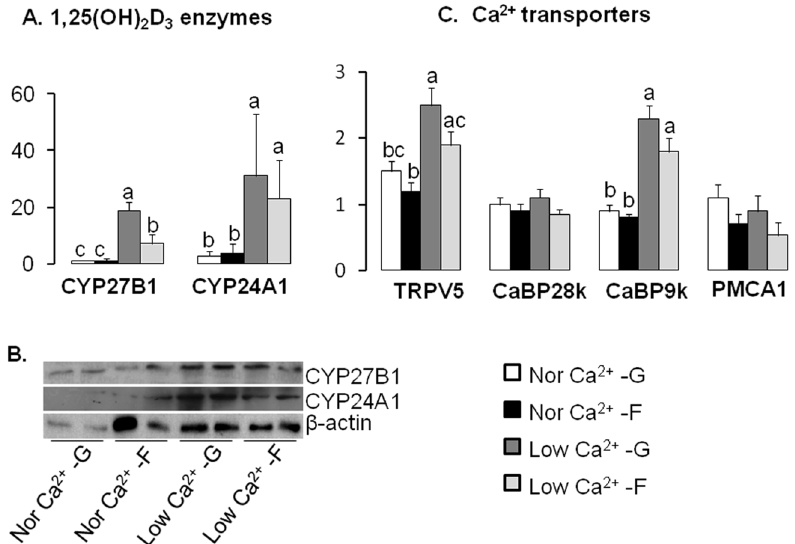
Figure 2. Fructose inhibits compensatory increases in renal expression of the 1,25(OH) 2 D 3 metabolizing enzyme CYP27B1 induced by dietary Ca 2 + deficiency in mice. (A) mRNA expression levels of renal CYP27B1 (1 a -hydroxylase) and CYP24A1 (24-hydroxylase). (B) The protein abundance of CYP27B1 and CYP24A1, using b -actin as a reference. (C) mRNA expression levels of renal TRPV6, CaBP28k, CaBP9k and PMCA1. Nor = normal; G = glucose; F = fructose. All mRNA expression level data were analyzed by real-time PCR using EF1 a as a reference and normalized to levels in mice fed glucose and normal Ca 2 + diet. Data are means 6 SEM ( n =5–6 per group). Differences ( P , 0.05) among means are indicated by differences in superscript letters, as analyzed by 1-way ANOVA LSD. Thus, within a gene of interest, bars with superscript ‘‘a’’ are . bars with ‘‘b’’ which in turn . bars with ‘‘c’’. Dietary fructose inhibits compensatory increases in renal expression of Ca 2 + transporters and 1,25(OH) 2 D 3 metabolizing enzymes induced by dietary Ca 2 + -deficiency.